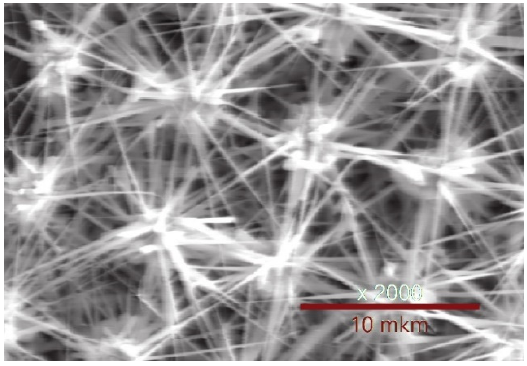
Figure 9. SEM image of ZnO nanowires on Si whiskers.